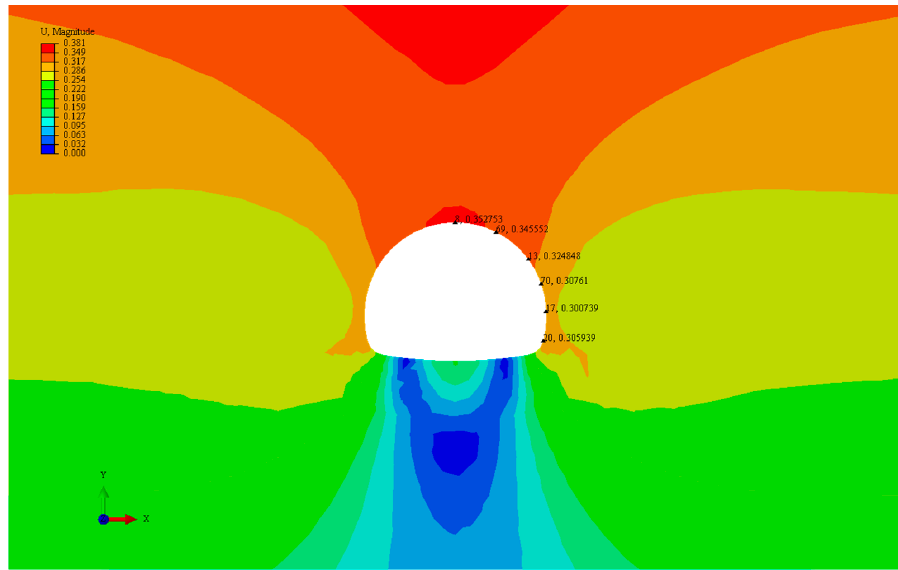
Figure 14. Contour map of tunnel displacement at rheological time 721 h.